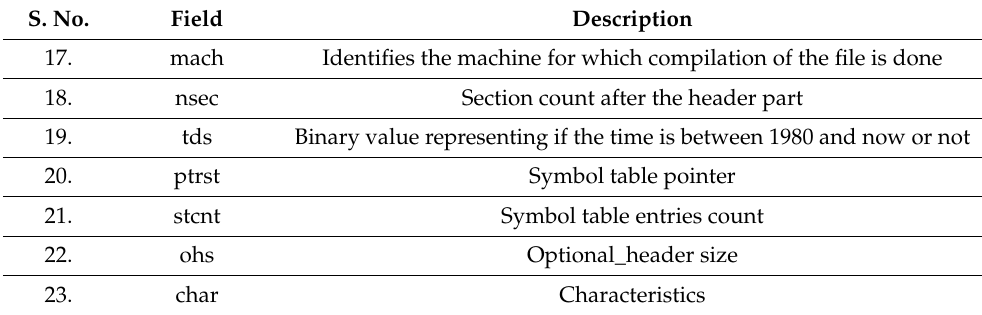
Table 2. Coff_header attributes of SOMLAP.